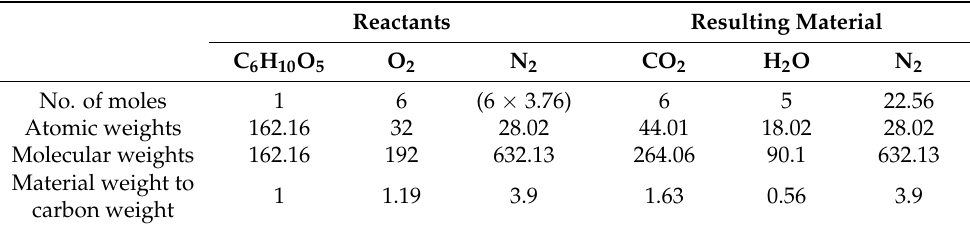
Table 7. The chemical properties of cellulose interacting with